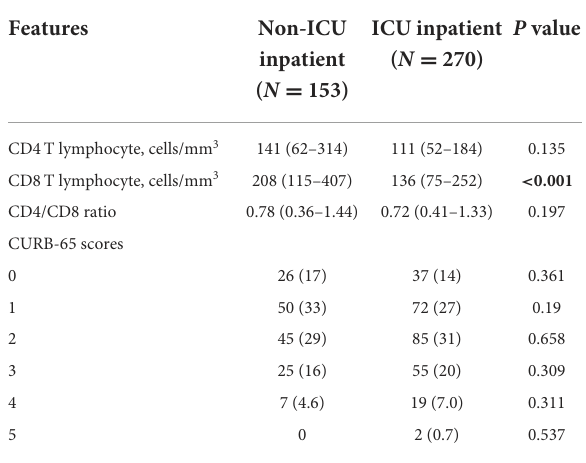
TABLE 3 Clinical features of ICU admission cases in the development